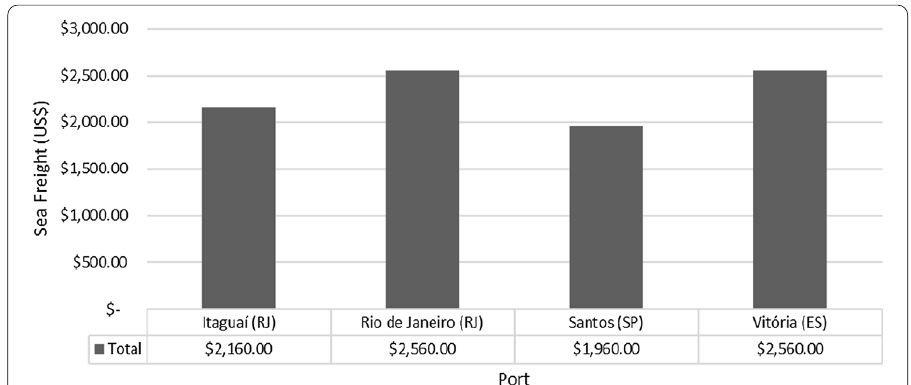
Fig. 4 Sea Freight Rate (US$) for importing a 40 ’container from Hong Kong to the analysed